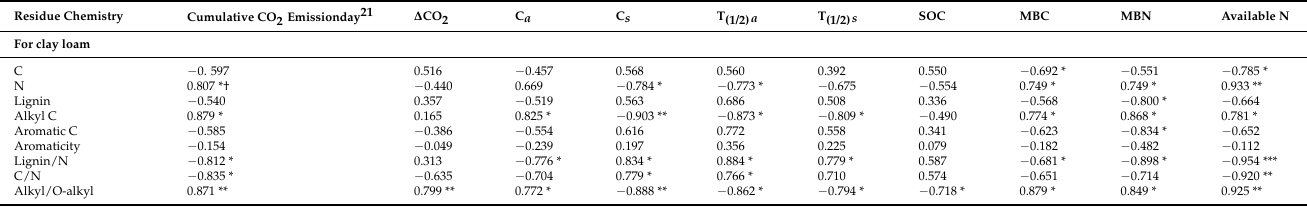
Table 6. Pearson linear correlation matrix of early cumulative CO 2 emission (21 days), ∆ CO 2 during whole incubation (61 days), first order decay model parameters, soil chemical and biochemical parameters in the two soils, total organic C and N, relevant NMR spectral regions and their ratios for the 7 types of crop